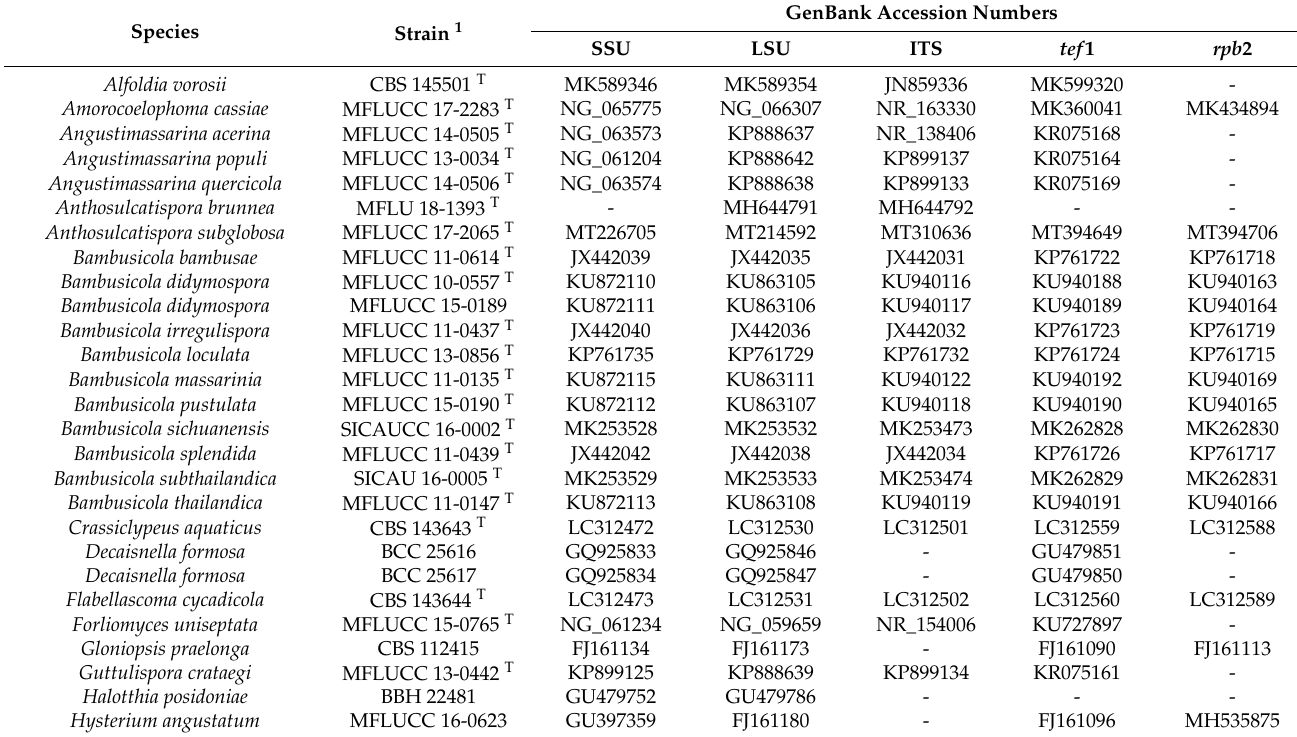
Table 1. Taxa used in the phylogenetic analyses and their corresponding GenBank numbers. Iso- lates/sequences in bold were isolated/sequenced in the present study. Species Strain